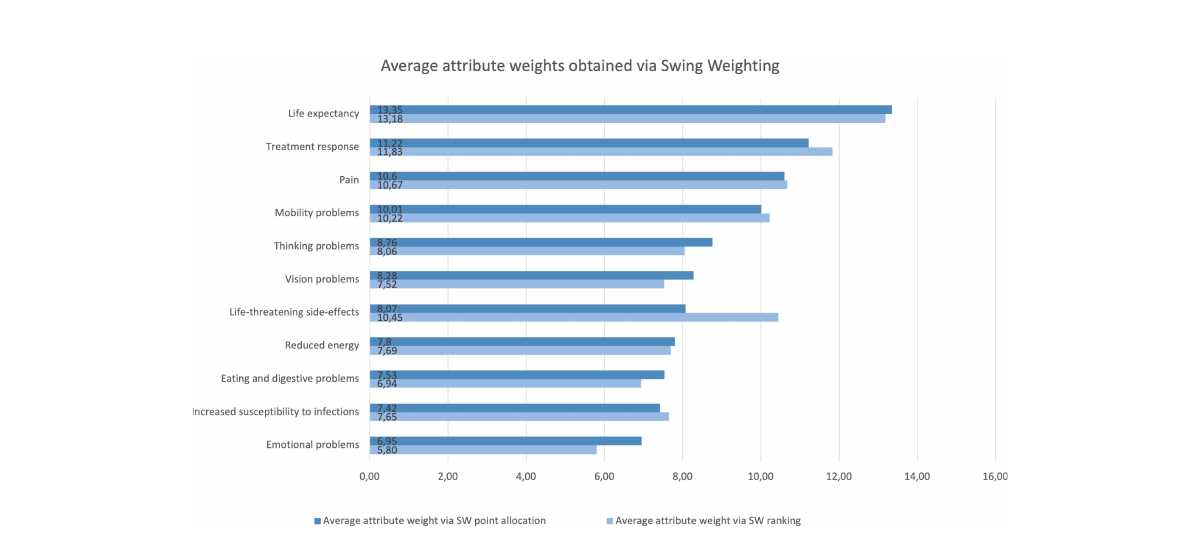
FIGURE 3 Rank order and relative importance of the attributes obtained through the SW ranking (light) and SW point allocation (dark) questions. Life expectancy was allocated the most points across the allocation questions. Life expectancy, treatment response, pain, and emotional problems received the fi rst and second position in both question types. Mobility and thinking problems scored among the six most important attributes in both SW question types. Conversely, increased susceptibility to infections, eating and digestive problems, and reduced energy scored among the fi ve least important attributes in both SW question types. While life-threatening side-effects scored 7 th in the SW allocation question, it is placed 4 th in the SW ranking question. Vision problems scored 6 th in the SW allocation question, and 9 th in the SW ranking question.